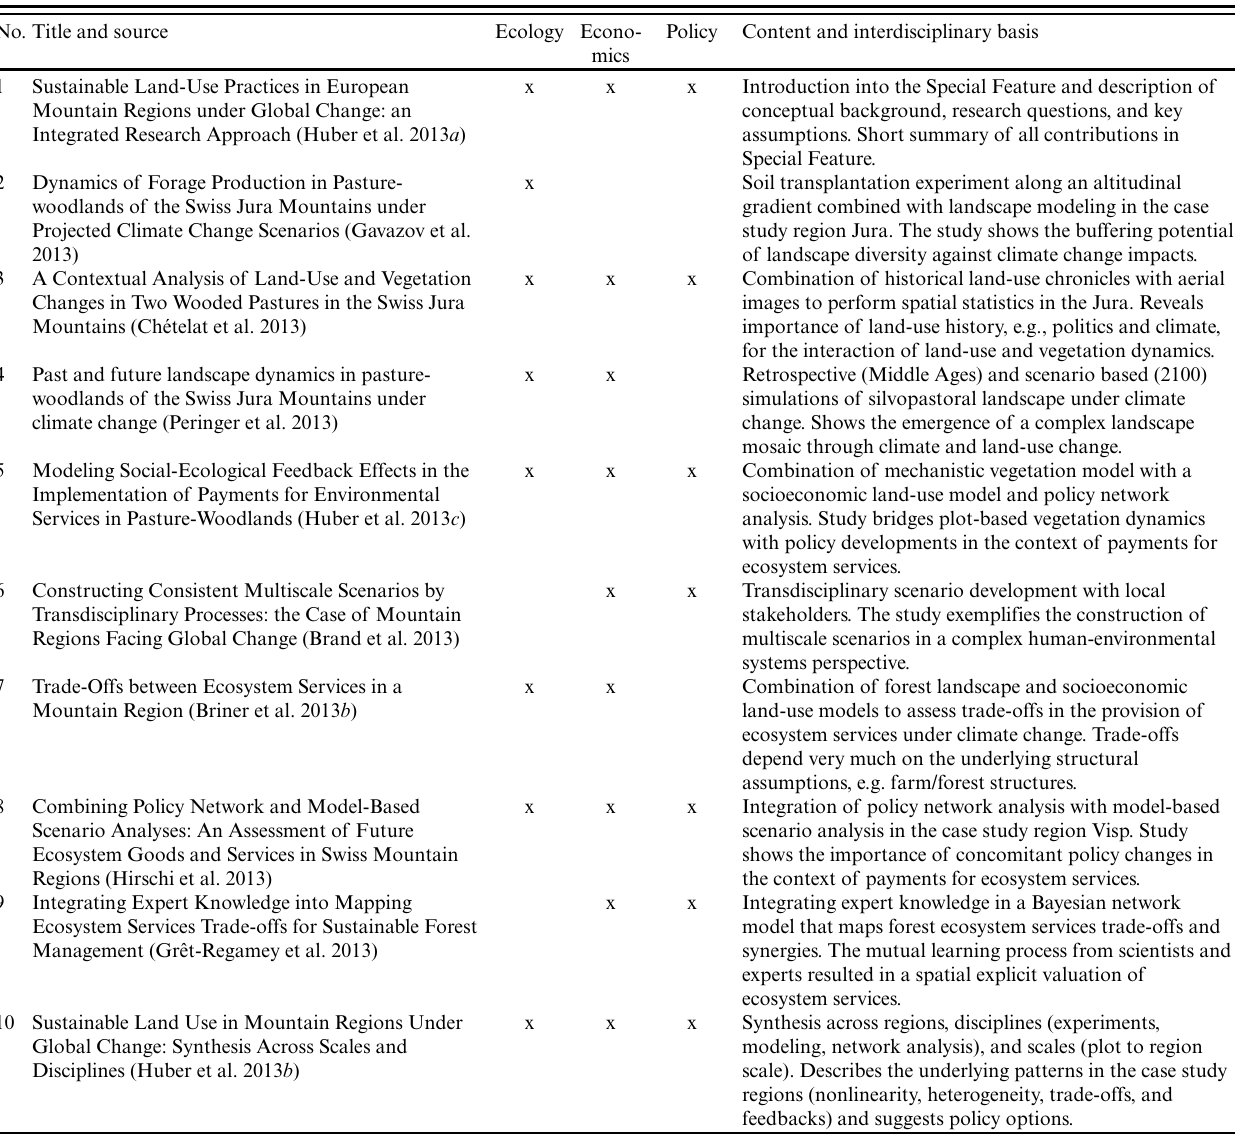
Table 1 . Overview of the“Mountland” Special Feature in Ecology and Society (http://www.ecologyandsociety.org/issues/view.php?